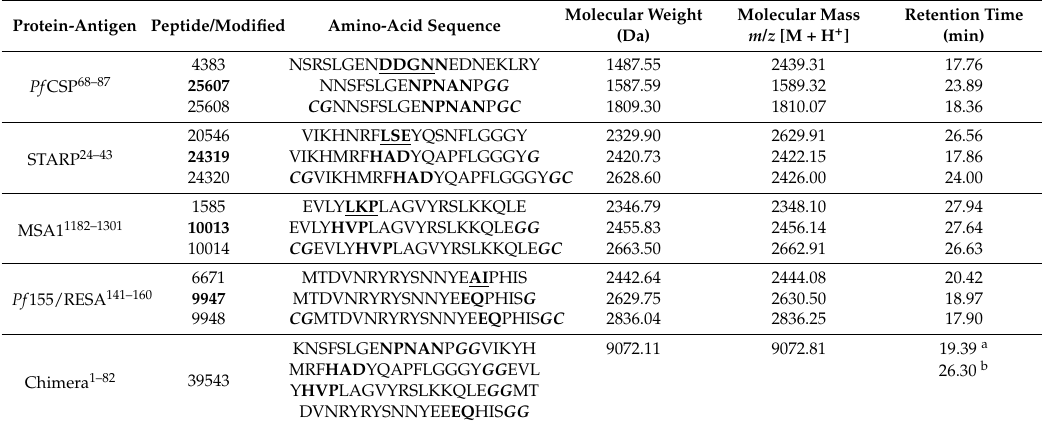
Table 1. Plasmodium falciparum targets and its large chimera immunogen